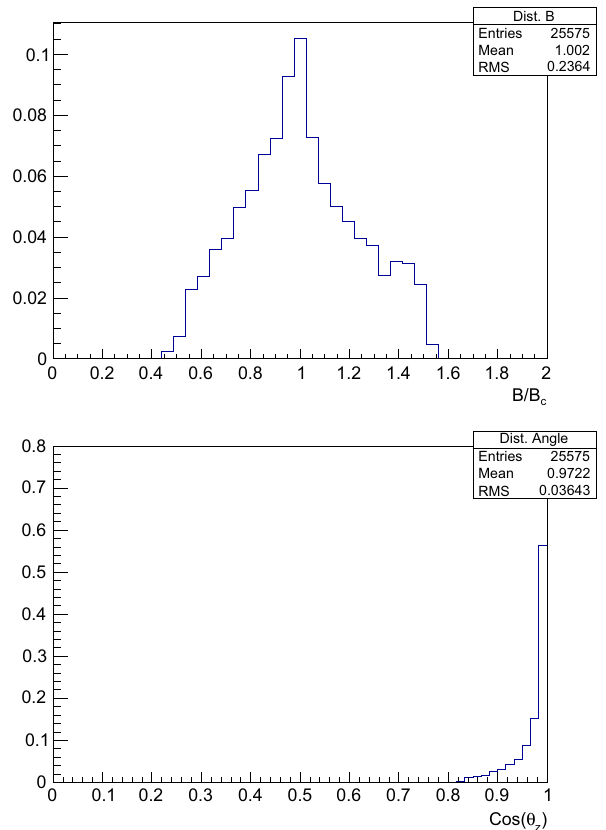
Fig. 2 Upper panel: distribution of magnetic field around the central value B c inside the trap. Lower panel: distribution of | cos θ z | values where θ z is the angle between vector B and vertical z